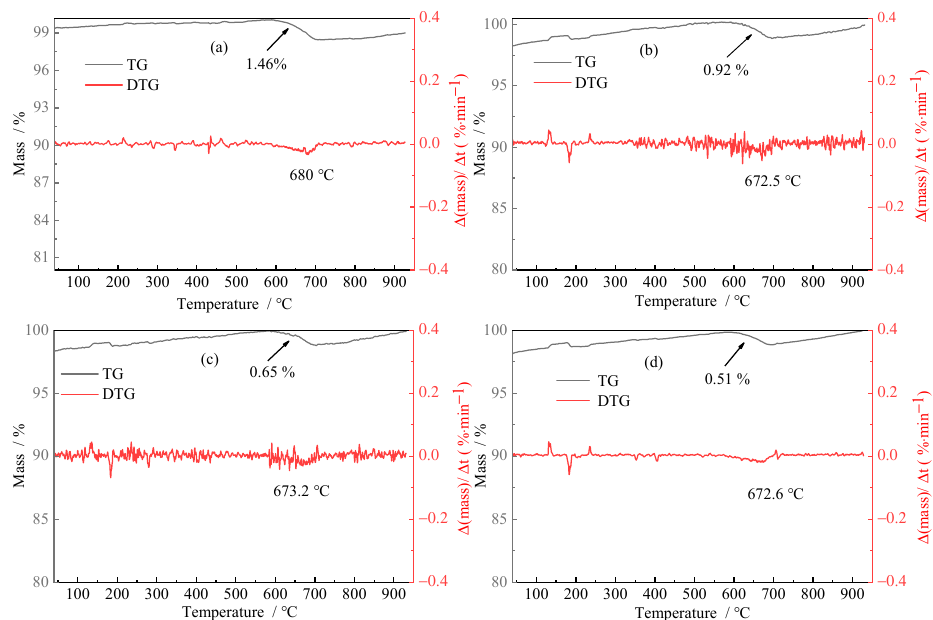
Figure 7. Thermogravimetric curves of anorthite and its leaching residue: ( a ) Anorthite; ( b ) Anorthite + distilled water; ( c ) Anorthite + sterile medium; ( d ) Anorthite + bacteria.